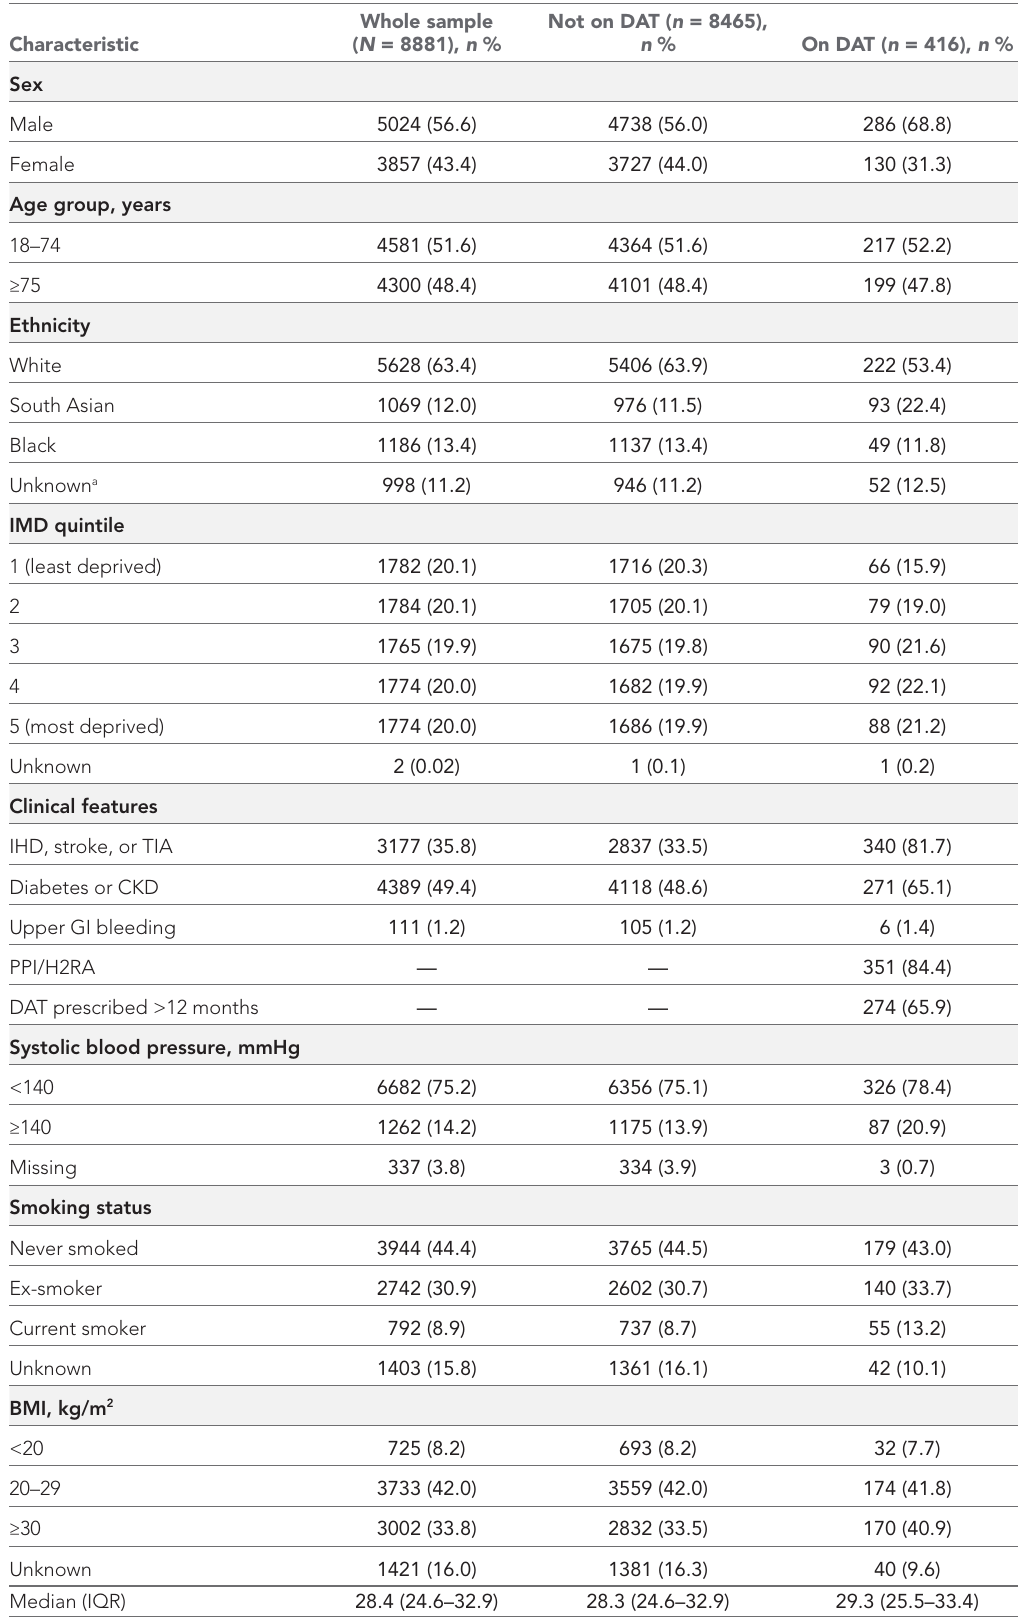
Table 1 Baseline patient characteristics of individuals with AF stratified by DAT prescription